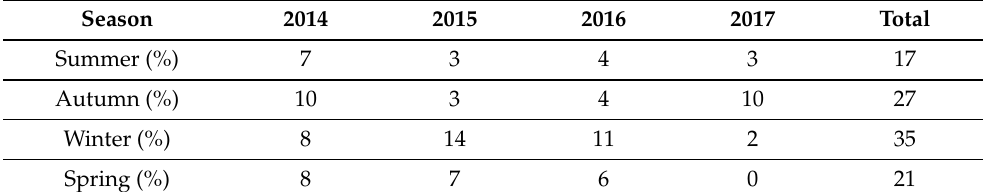
Table 3. Percentage analysis of outages per season.